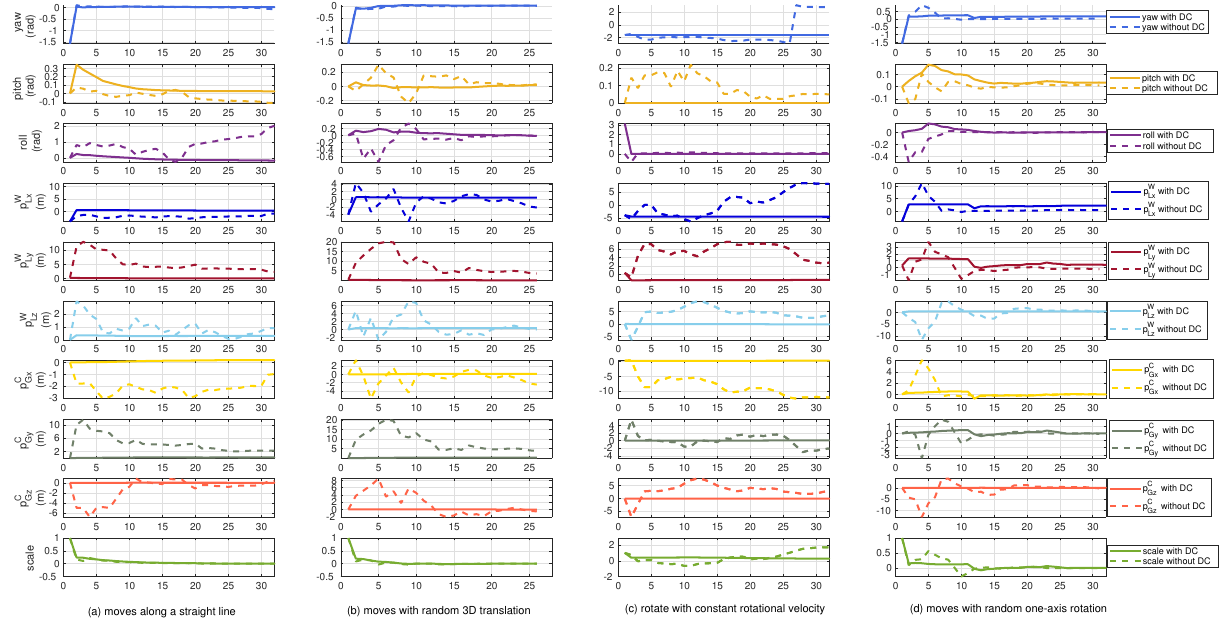
(d) moves with random one-axis rotation (c) rotate with constant rotational velocity